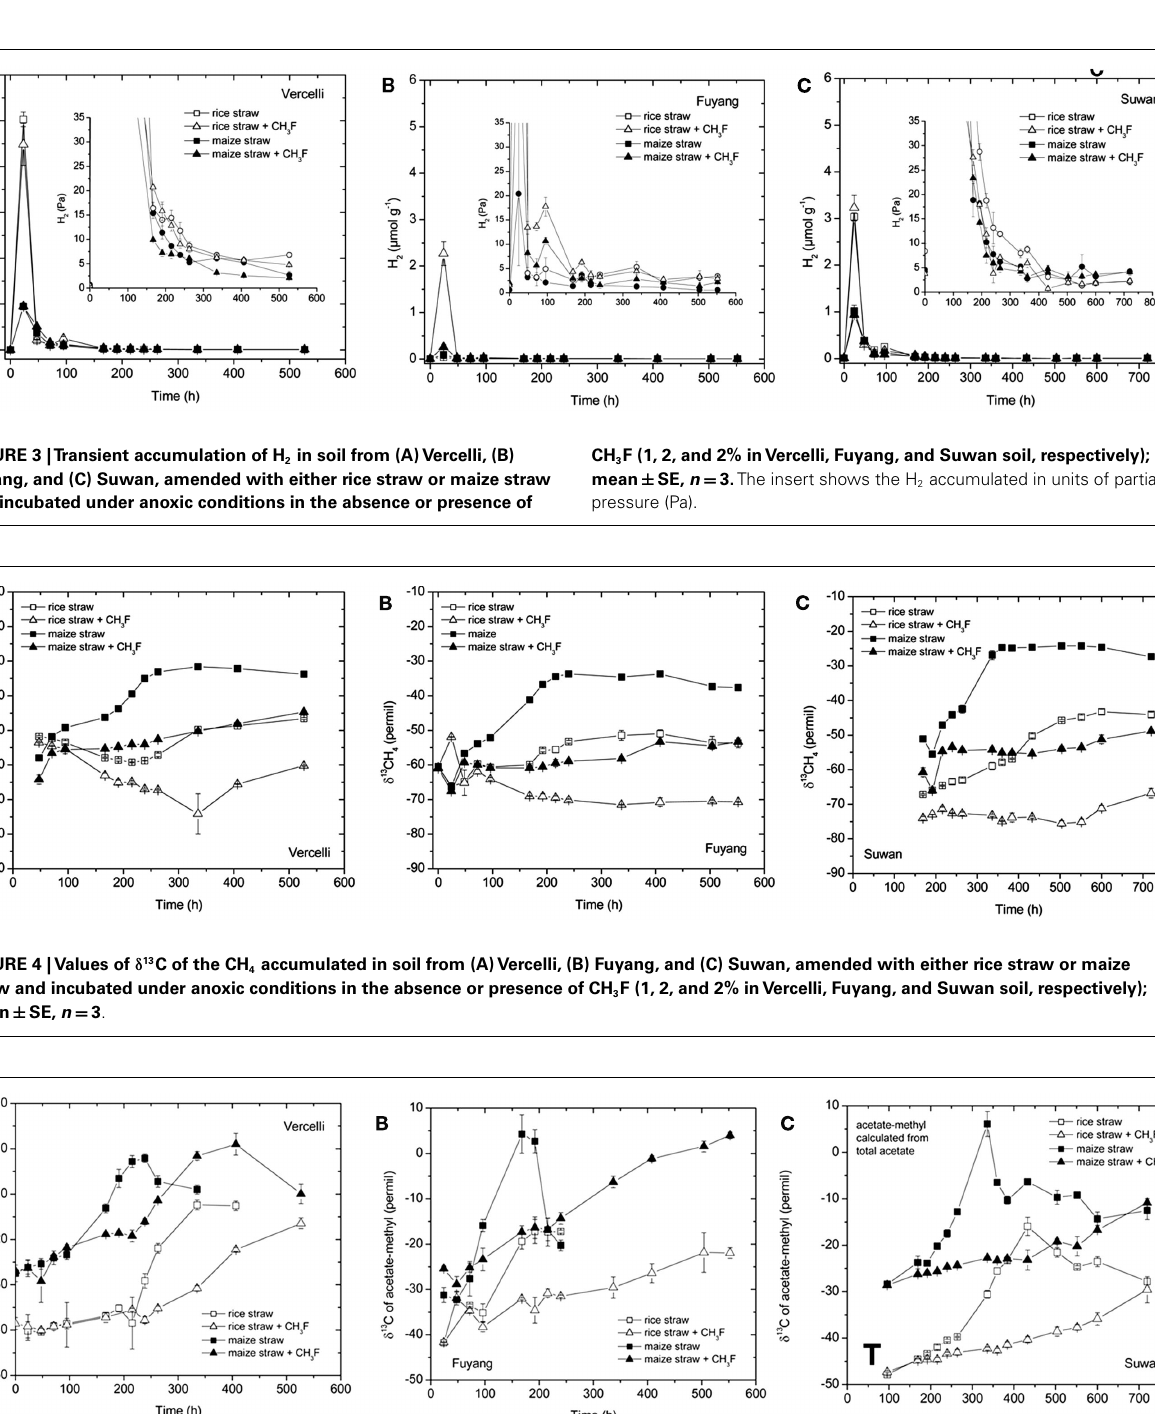
inVercelli, Fuyang, and Suwan soil, respectively); mean ± SE, n = 3. The data inVercelli and Fuyang soil were directly measured; those in Suwan soil were calculated from measured δ 13 C of total acetate using δ 13 C = δ 13 C − ac − methyl ac